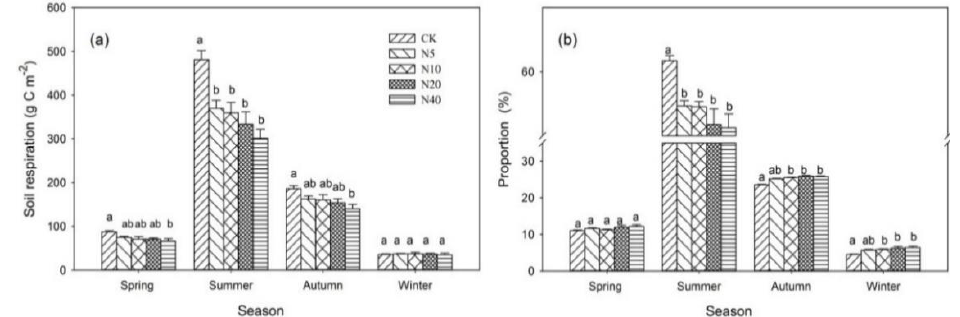
Figure 2. Seasonal cumulative soil respiration ( R S ) ( a ) and variation in the seasonal proportion of R S ( b ) under di ff erent nitrogen rates. Di ff erent lowercase letters in the same column indicate a significant di ff erence ( p < 0.05, n = 4) among the five nitrogen addition rates. Table 4. Significance of the e ff ects of nitrogen addition and seasonal variation on seasonal cumulative soil respiration ( R S ) as assessed by two-way ANOVA.